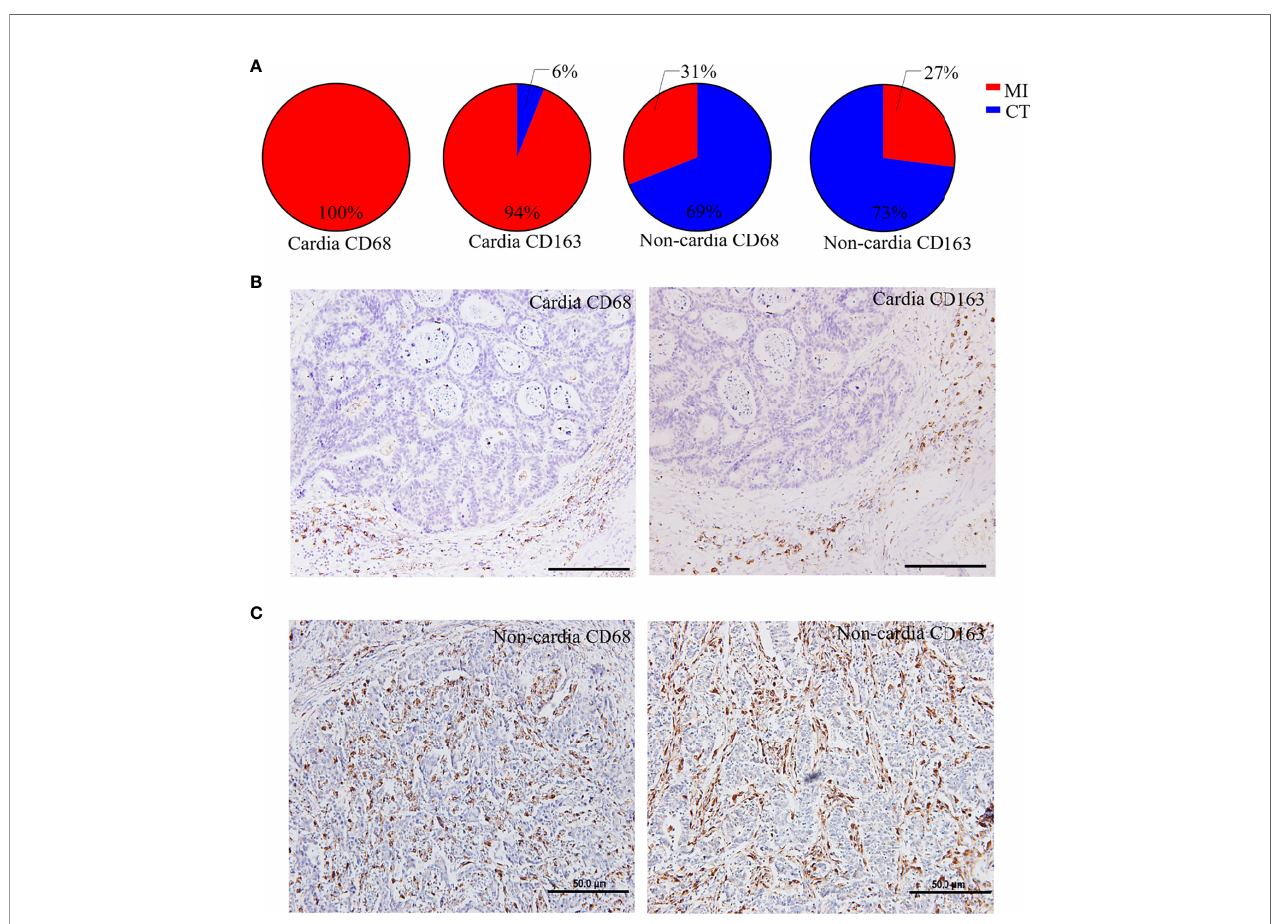
FIGURE 1 | Distinct distribution of macrophages in CGC and NCGC. (A) The proportion of the distribution type of CD68 + or CD163 + macrophages in cardia and non-cardia tumor tissue samples, respectively. Representative picture of immunohistochemical staining of CD68 + or CD163 + macrophages in cardia (B) and non- cardia (C) gastric cancer tissues. CT, core of primary tumors; MI, invasive margin of primary